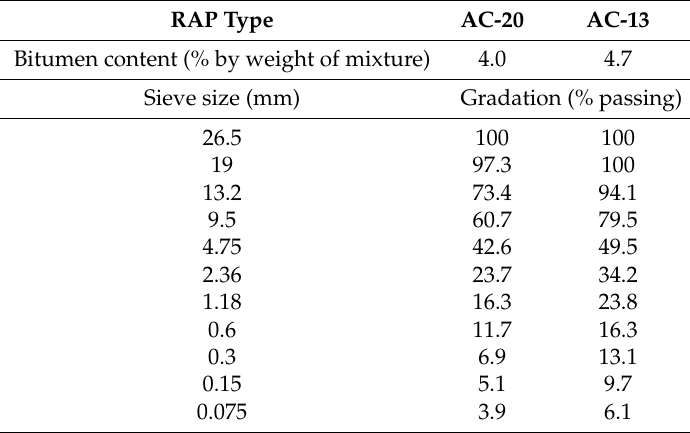
Table 4. RAP gradation and bitumen content (after